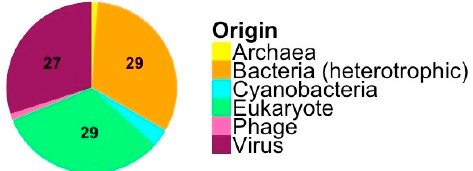
Figure 2. Presumed origin of 90 genes with a functional annotation in the four M. pusilla